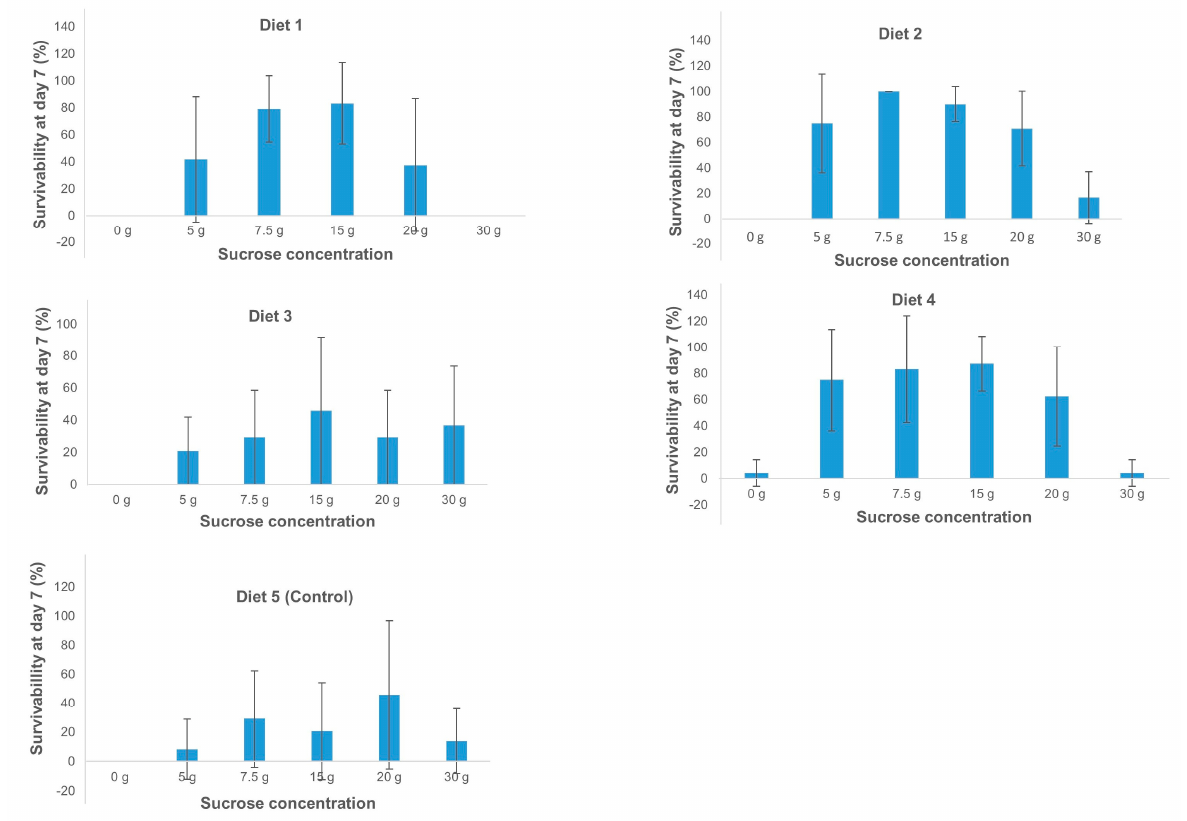
Figure 1. Survivability of banana aphids at day 7 post-feeding on various diets supplemented with different concentrations of sucrose. Data are presented as mean percentage survivability (%) and error lines indicate the standard